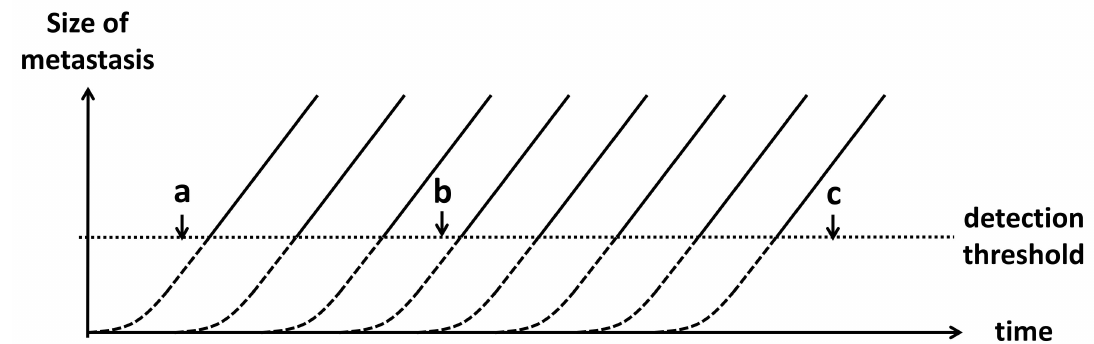
Figure 1. Growth of metastases in time. Metastases are considered undetectable when their size is below the detection threshold (dashed lines), and thus become detectable above the detection threshold (solid lines). If a patient is scanned at time “a”, all metastases are invisible, and this patient would be considered to be “recurrence-free”. At time “b”, three recurrences would be visible on the scan. This is defined as an oligo-metastasis, even though there are several metastases under the detection threshold (oligo+). At time “c”, 8 recurrences are visible on the scan, which is defined as poly-metastatic